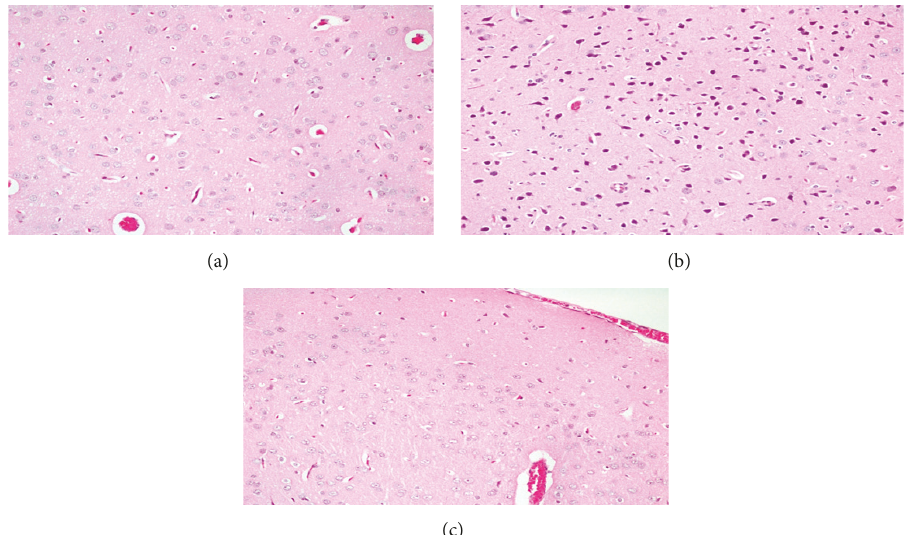
Figure 3: (a) Histopathological image of section of the brain of a control rat. The image shows normal cells in the brain. (b) Histopathological image of section of the brain of rat treated with AlCl 3 . It shows numerous small dark cells with no nucleus which are apoptotic cells. (c) Histopathological image of section of the brain of AlCl3 exposed rats pretreated with quercetin and 𝛼 -lipoic acid treated rat. It shows normal cells with fewer apoptotic